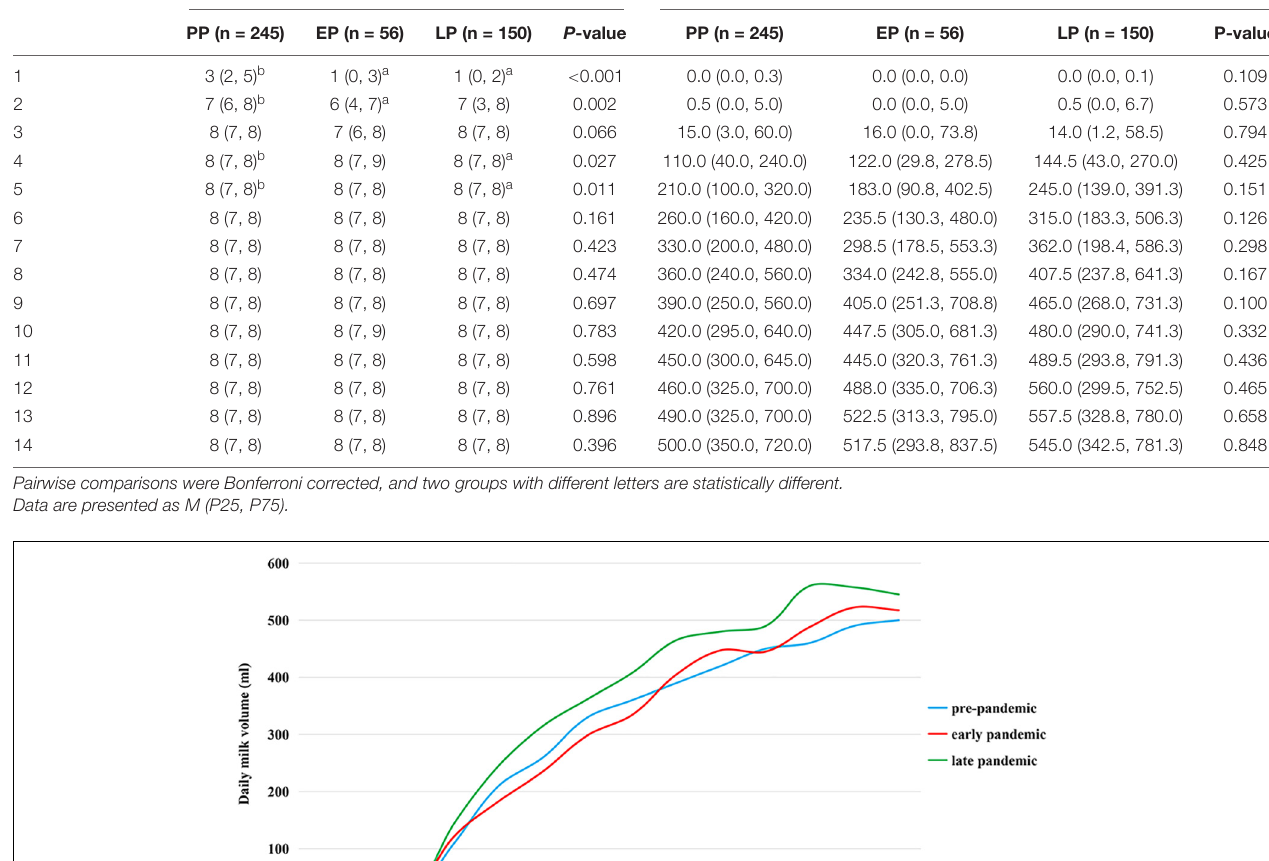
(EP, 42.9% vs PP, 81.7% or LP, 82.4%, P corrected < 0.05).